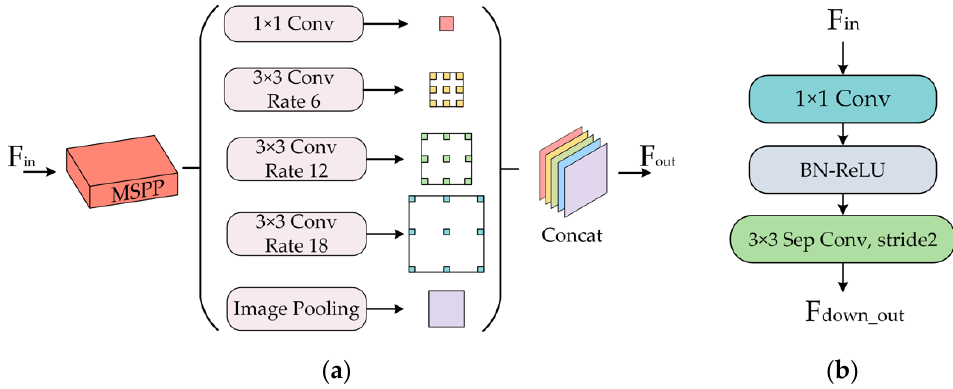
Figure 3. ( a ) The MSPP, which serves to fuse multi-scale shallow features with deep features. ( b ) Down-sampling (Down)